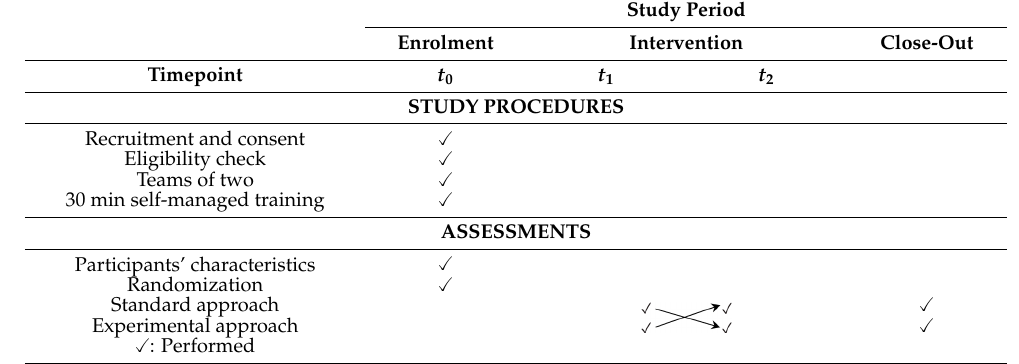
Figure 2. Study sequence. Table 1. Trial